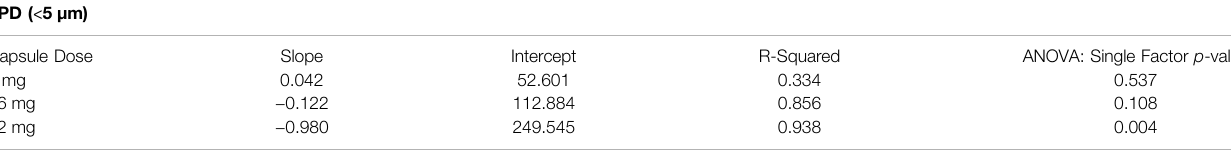
FPD, fi ne particle dose.